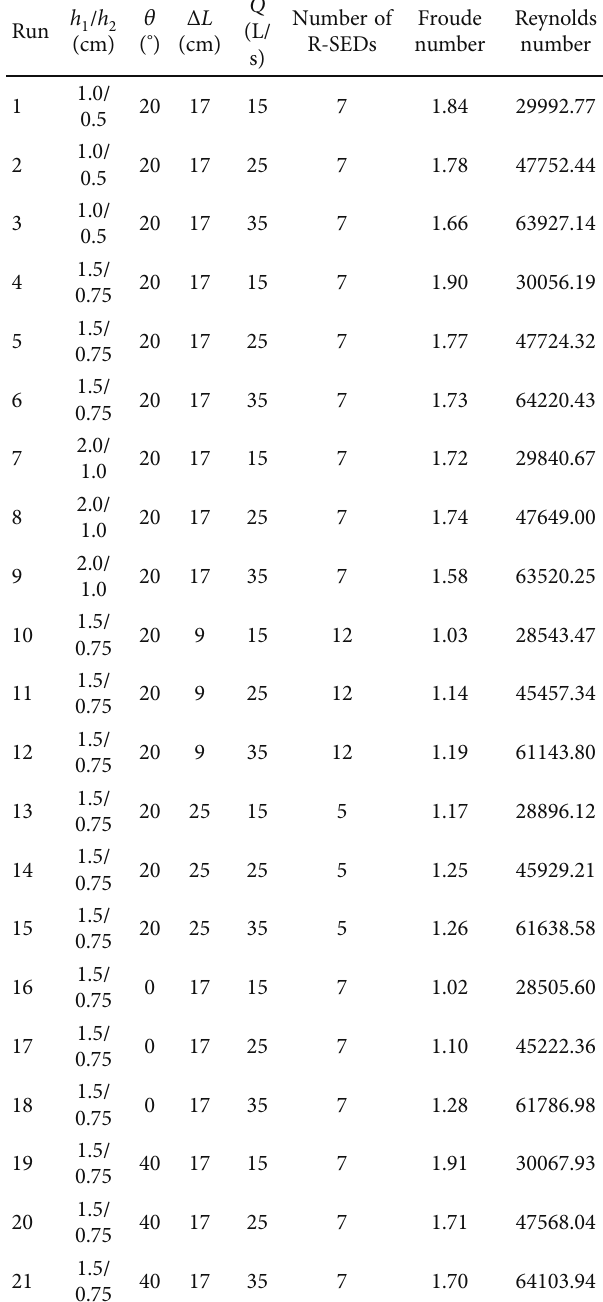
Table 1: Parameter settings of test